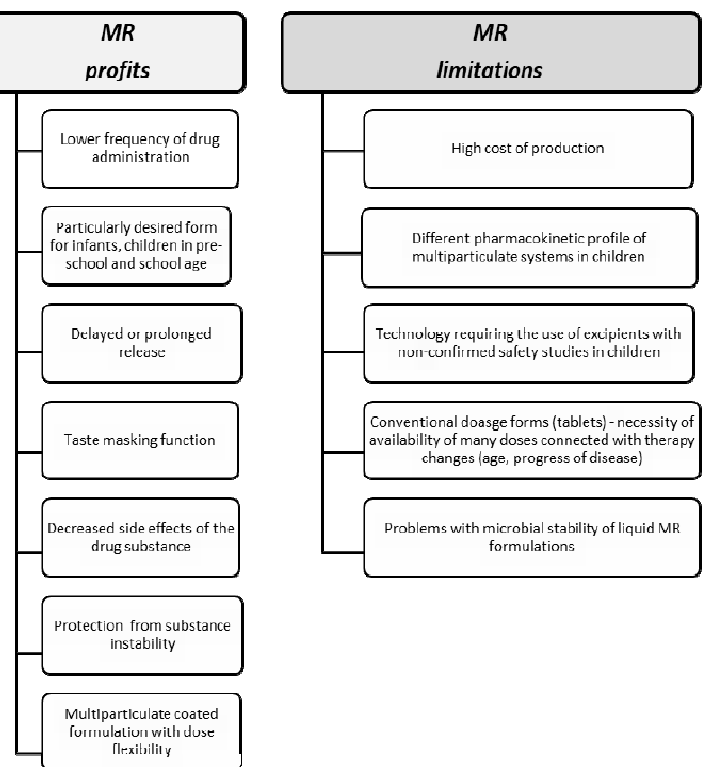
Figure 2. Profits and limitations of use the modified release (MR) formulations in paediatric population.